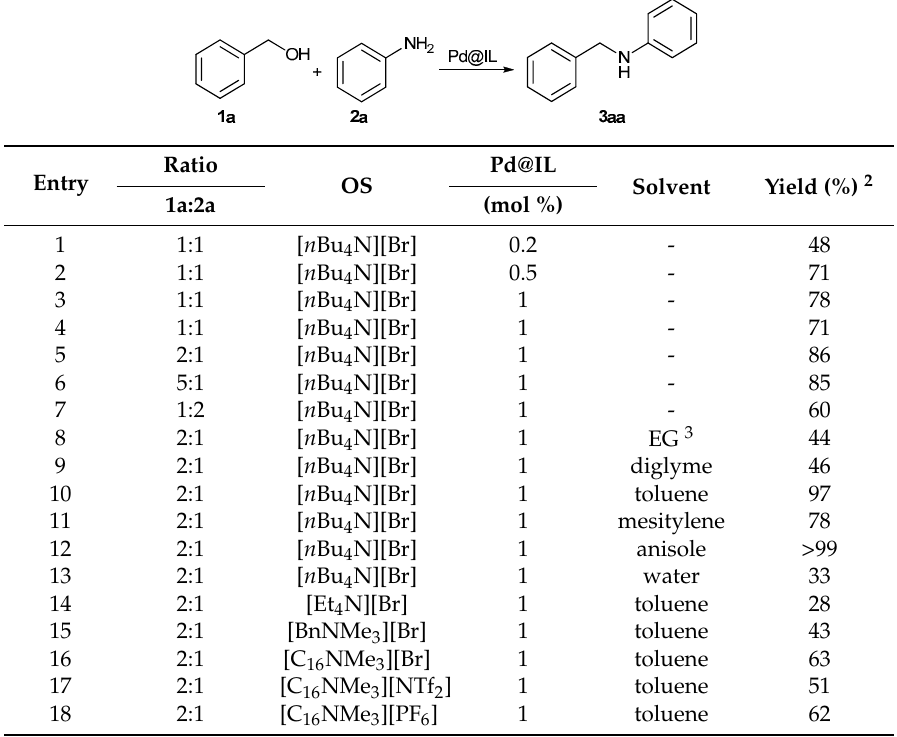
Table 1. Optimization of N- alkylation of aniline with benzyl alcohol 1 .